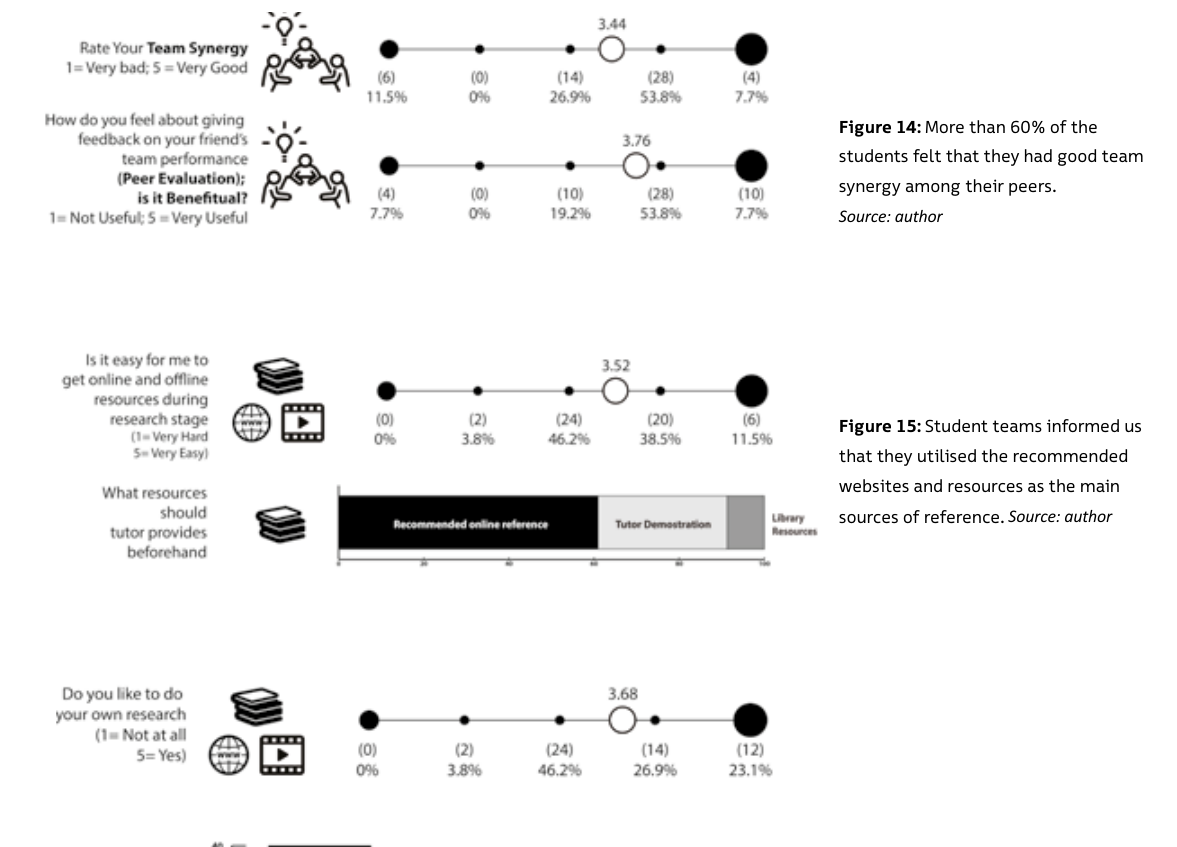
Figure 16: A majority of their research